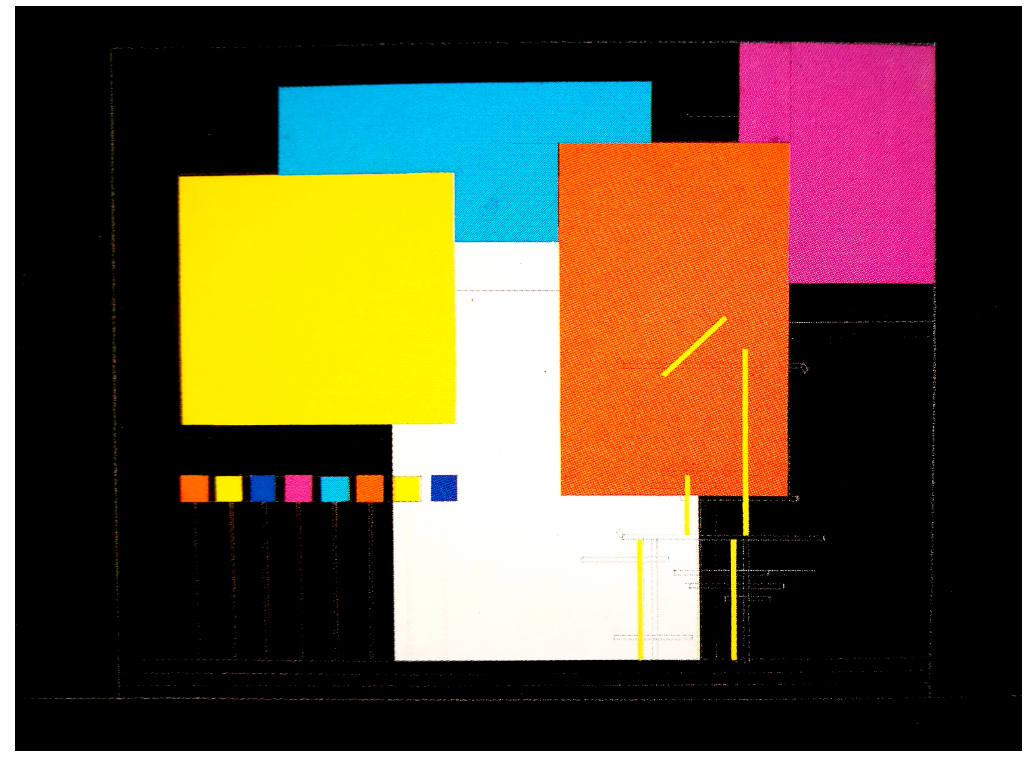
Figure 2. O. Schlemmer, Le Rossignol, The imperial throne, II act, working drawings,